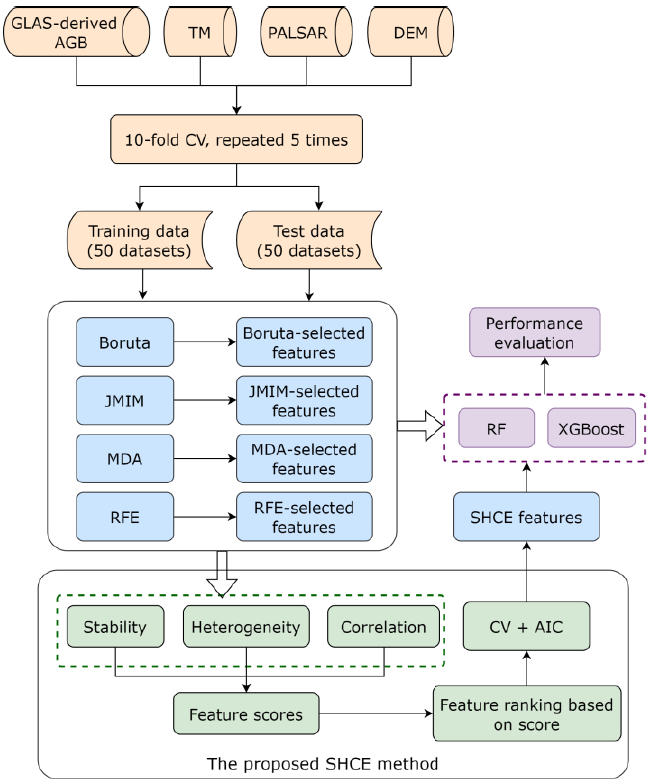
Figure 2. Flowchart illustrating feature selection for forest AGB estimation.